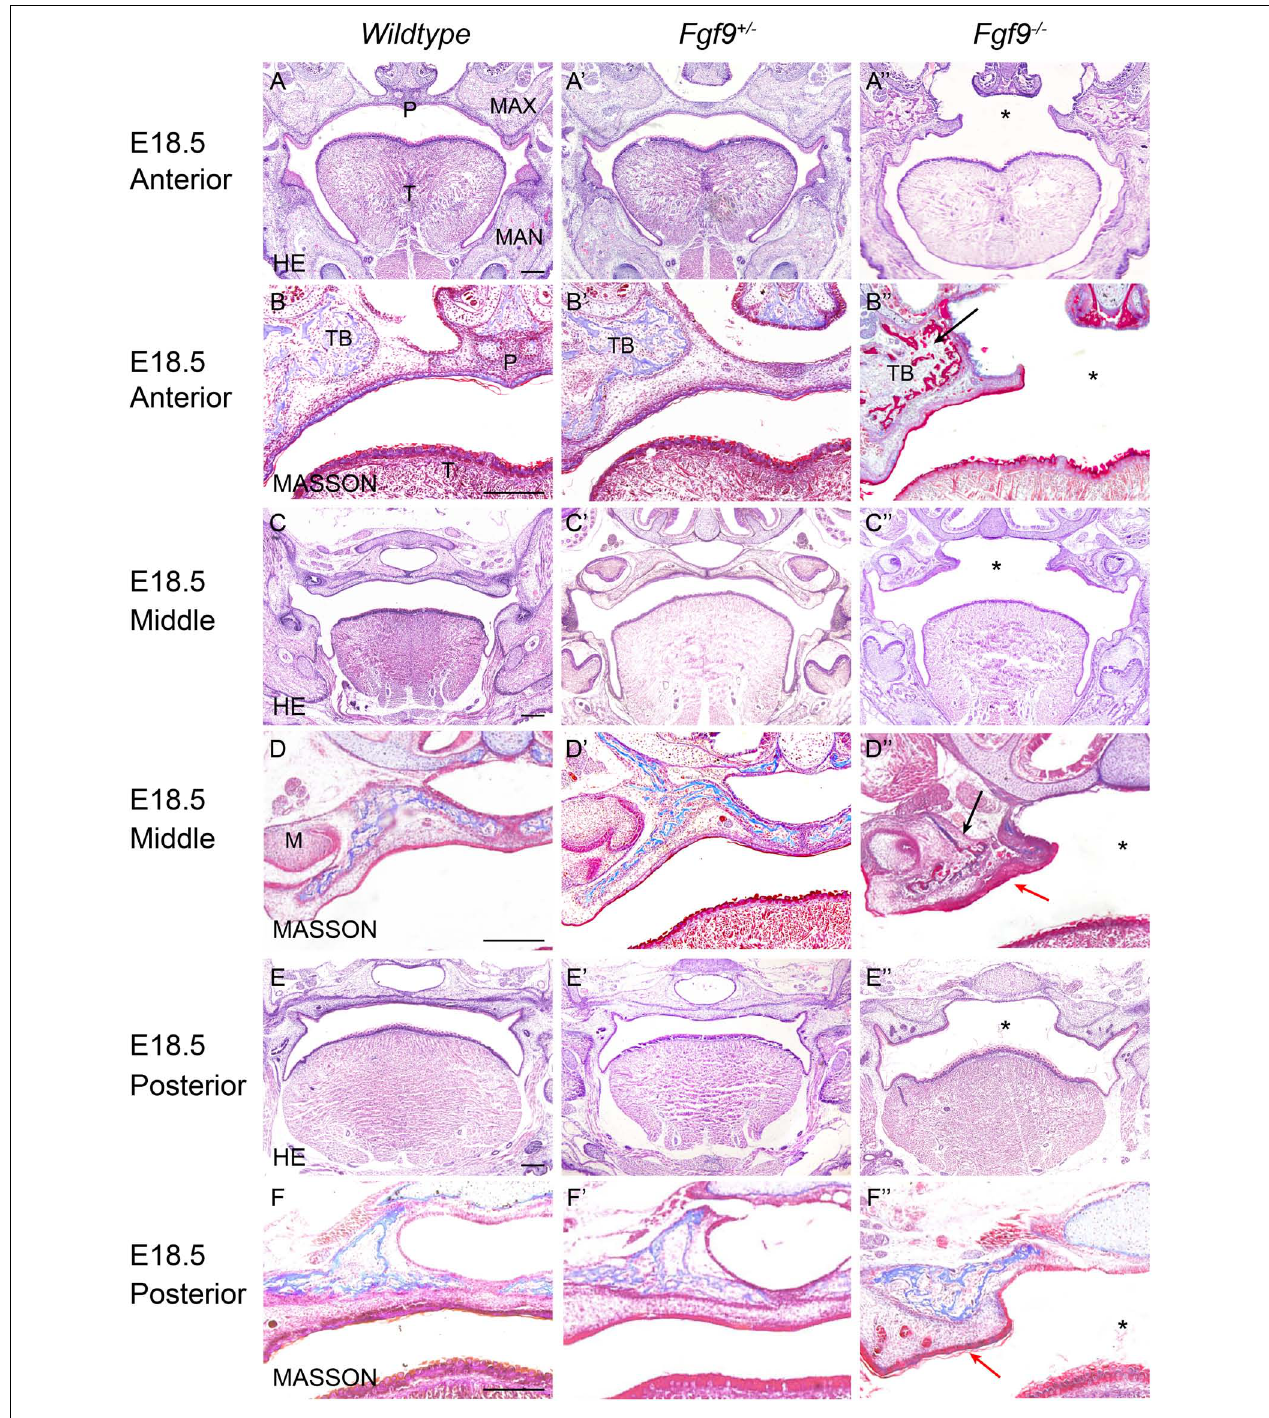
FIGURE 3 | Aberrant morphology and fusion failure in Fgf9 − / − embryos at E18.5. The HE staining of (A–A”) anterior, (C–C”) middle, and (E–E”) posterior palate in Wildtype, Fgf9 + / − and Fgf9 − / − embryos The magnified view showing MASSON staining of (B–B”) anterior, (D–D”) middle, and (F–F”) posterior palate in Wildtype , Fgf9 + / − , and Fgf9 − / − embryos. Black arrows indicate the premature trabecular bone development. Red arrows indicate the thickened cuticular layer. *, cleft secondary palate. P, palate. MAX, maxilla. MAN, mandible. T, tongue. TB, trabecular bone. M, molar. Scale bars = 200 µ m.